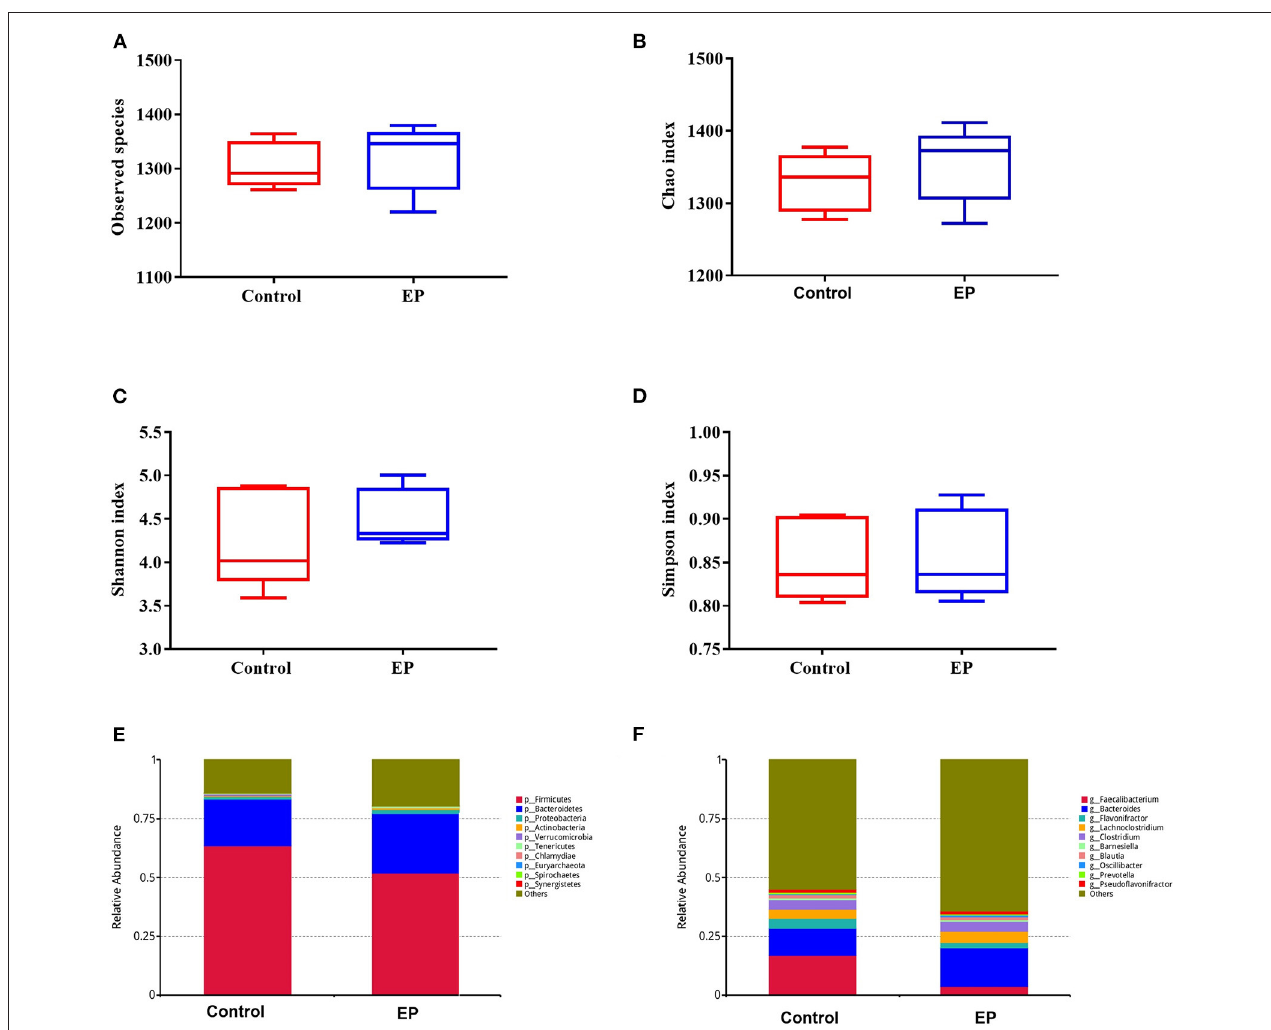
FIGURE 5 | The alpha diversity and the relative abundances of caecal microbiota from the EP and control groups broiler chickens. The number of observed species (A) , Chao index (B) ; Shannon index (C) ; Simpson index (D) ; the relative abundance of major bacterial phyla (E) ; and major bacterial genus (F) between the EP and control groups. EP, Enteromorpha prolifera